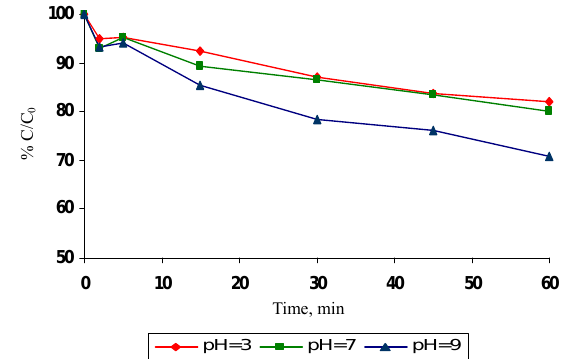
] = 5.64 mg/L; [4NCB] 3 o